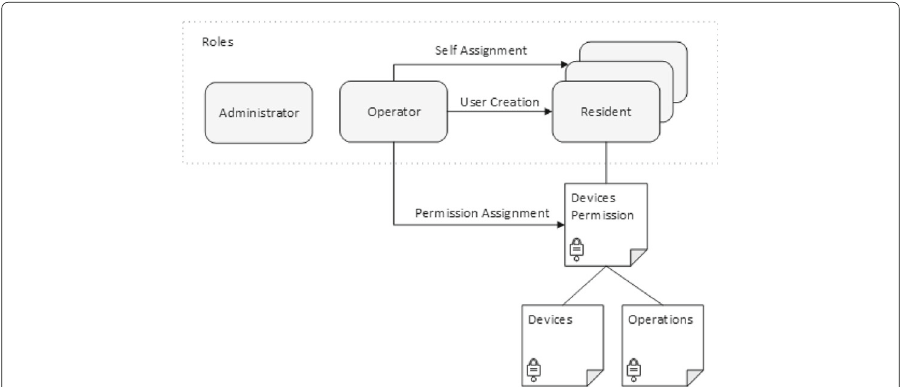
Fig. 2 The three user roles of the generic user interface for building operating systems in smart